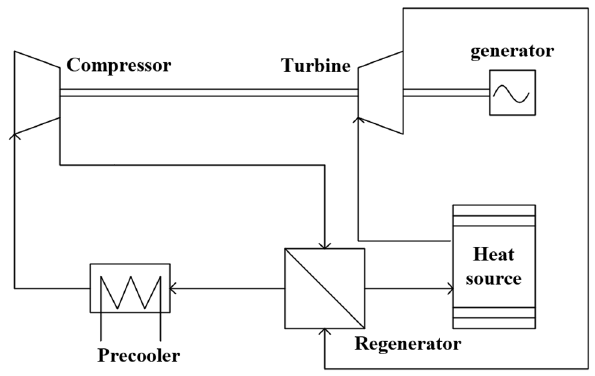
Figure 1. Diagram of a simple Brayton cycle.